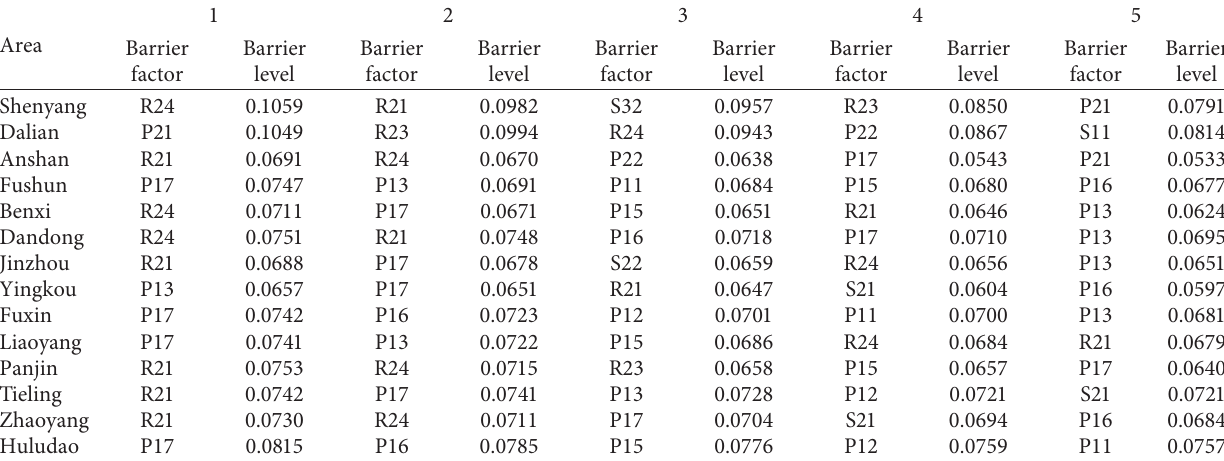
Table 4: Main constraint factors of industrial ecosystem development of 14 cities in Liaoning Province in 2018.